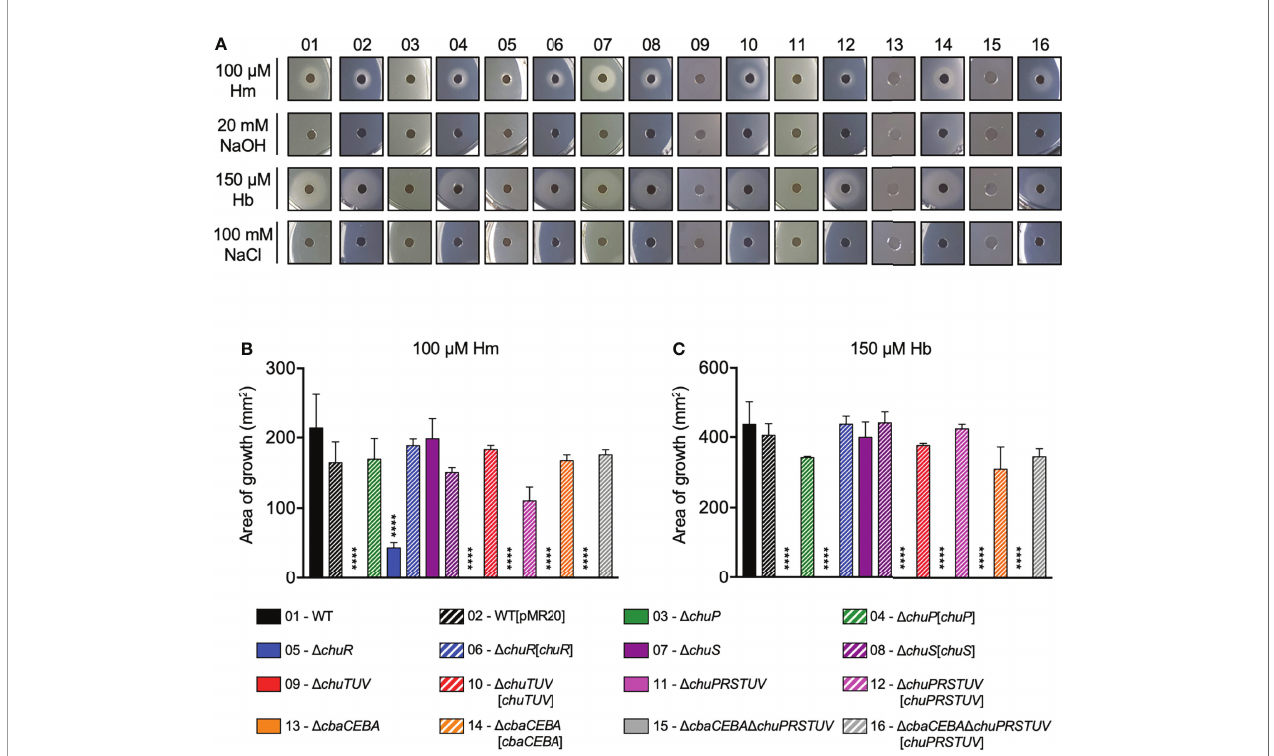
FIGURE 2 | The chu operon encodes a heme uptake system (ChuRTUV) and a regulatory protein (ChuP) required for heme and hemoglobin utilization. (A) Nutrition assay for Hm and Hb under DP-imposed iron de fi ciency. The indicated strains were embedded into M9CH medium supplemented with 125 m M DP. Aliquots of 100 m M Hm and 150 m M Hb were provided as iron sources, while 20 mM NaOH and 100 mM NaCl were used as negative controls. Growth halos around the discs indicate compound utilization. Representative images are shown. (B, C) Quanti fi cation of Hm and Hb-stimulated growth. The area of the growth halos stimulated by Hm (B) and Hb (C) was measured using Image J software by subtracting the area of the discs. Data are from three biological replicates. Mutant and complemented strains were compared to WT and WT[pMR20], respectively. ****p < 0.0001; when not indicated, not signi fi cant. One-way ANOVA followed by Tukey ’ s multiple- comparison